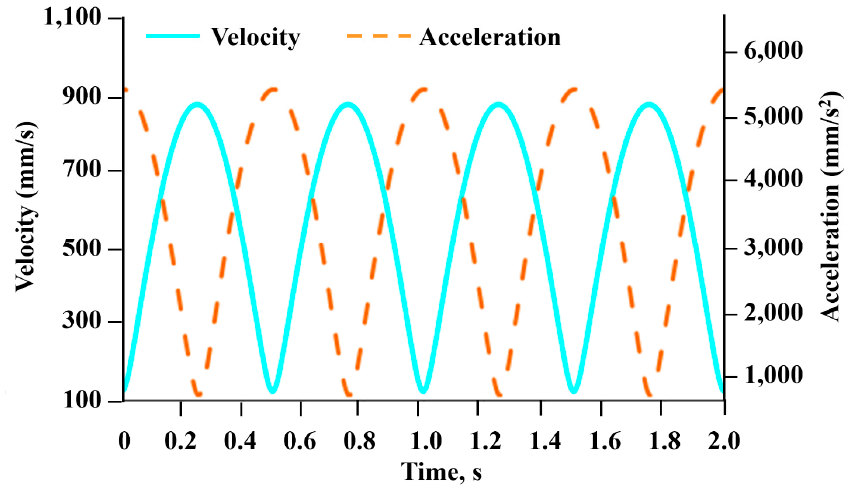
Figure 10. Velocity (mm/s) and acceleration (mm/s 2 ) of the dibbling hopper for all combinations as a function of time (s).